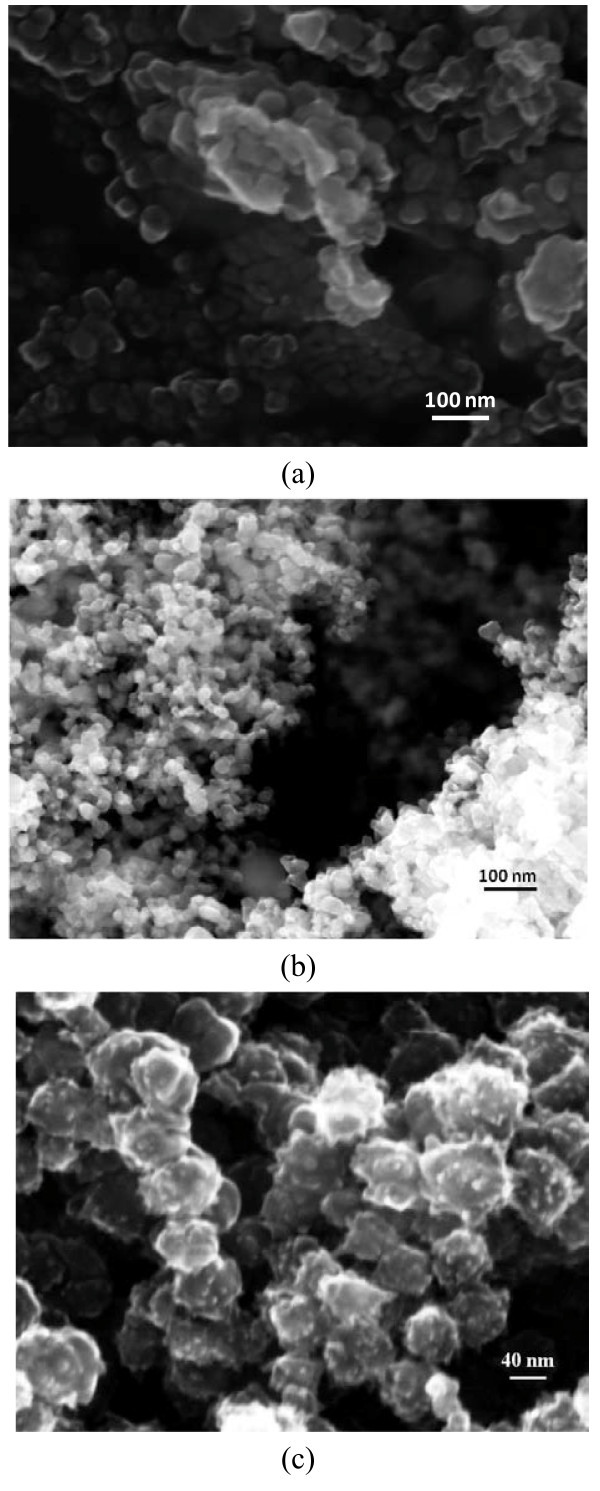
SEM images of nanoparticles. (a) CuO, (b) TiO2 and (c) SWCNH nanoparticles.